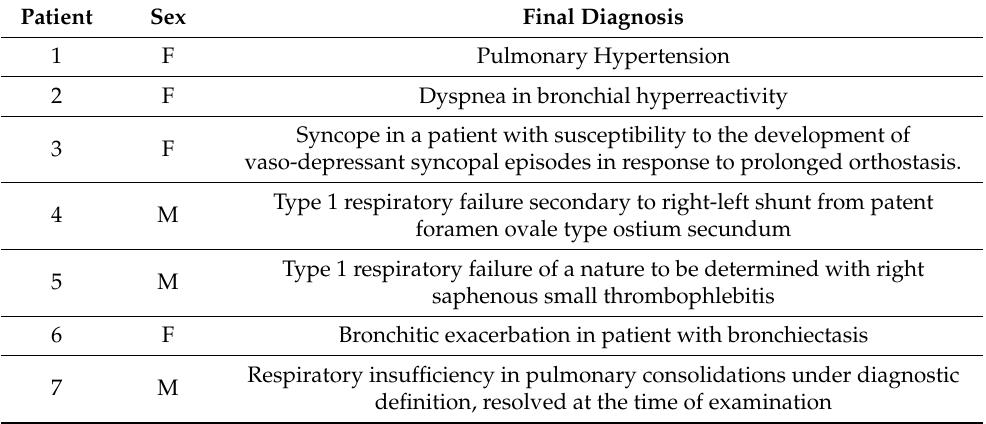
Table 3. Final diagnosis in seven patients free from pathological ultrasound findings.